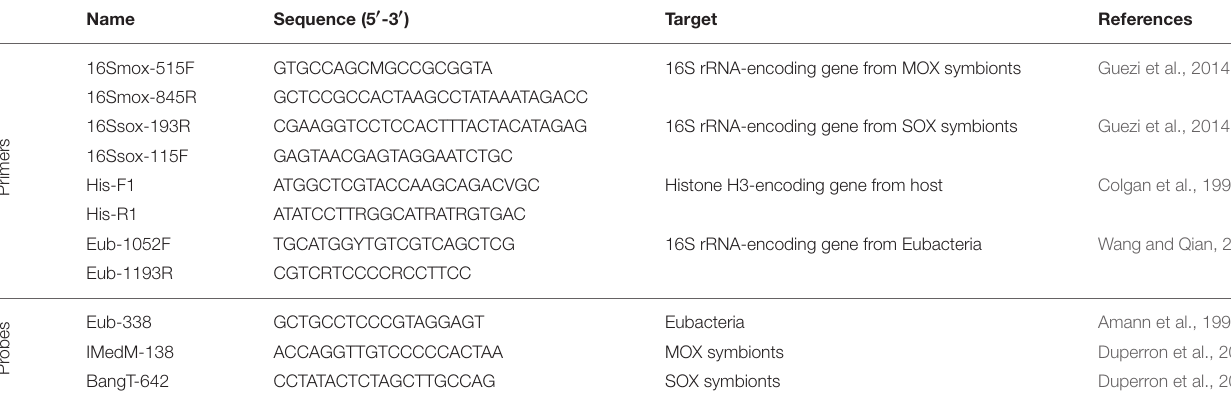
TABLE 2 | Primers used for qPCR and probes used for FISH in this